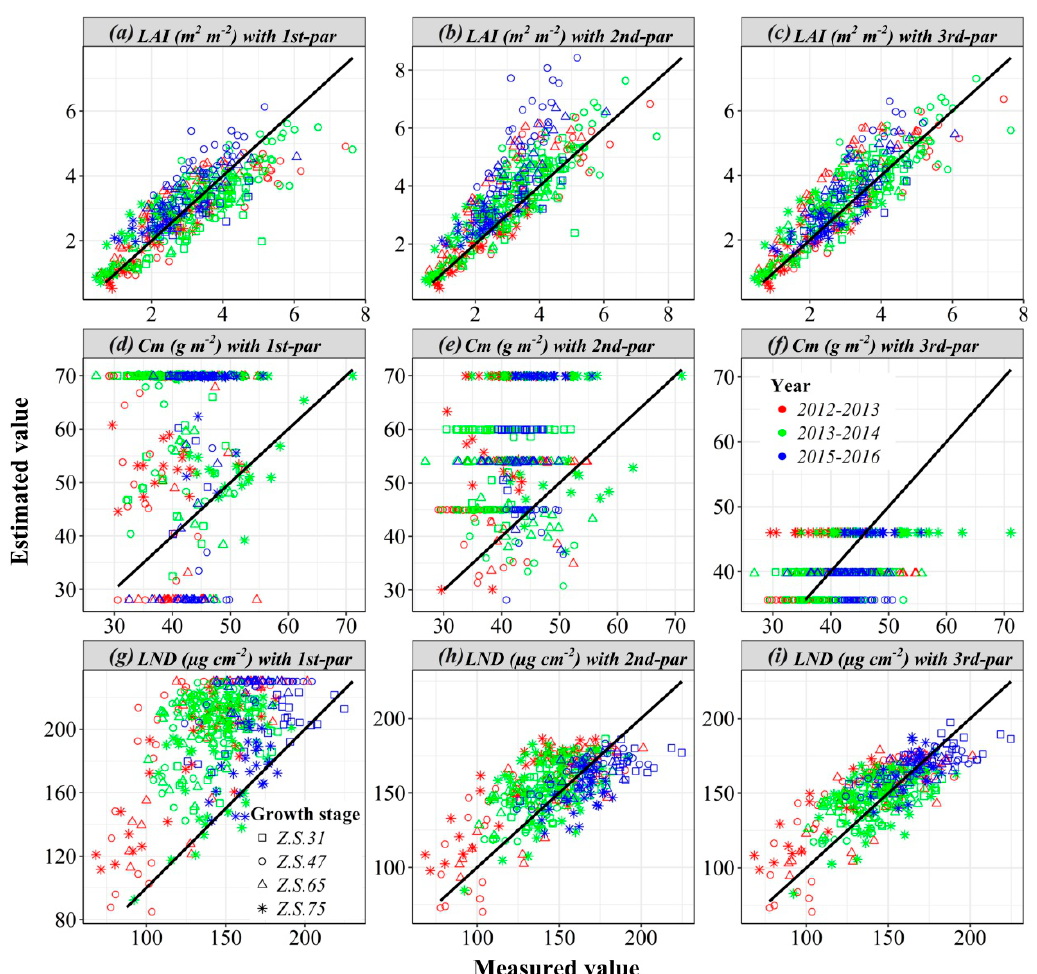
Figure 3. Comparison of measured and estimated values of leaf area index (LAI) ( a – c ), Cm ( d – f ), and LND ( g – i ) based on the N-PROSAIL model in winter wheat across the calibration set. Table 7. Comparison of different agronomic parameters estimation with different parameter setting. Paramet er Setting